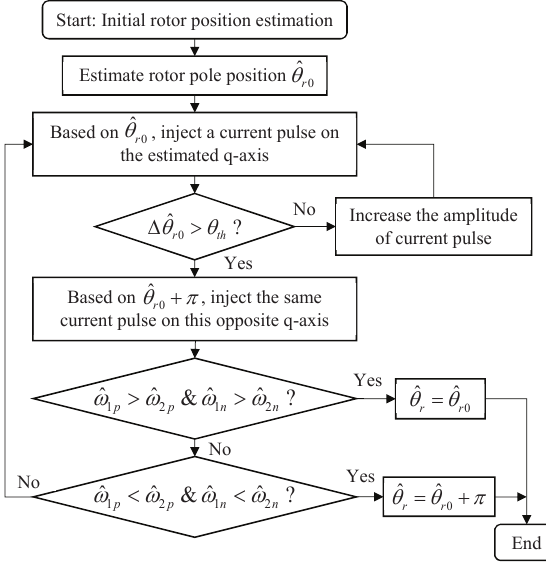
Figure 9. Procedure of initial rotor position